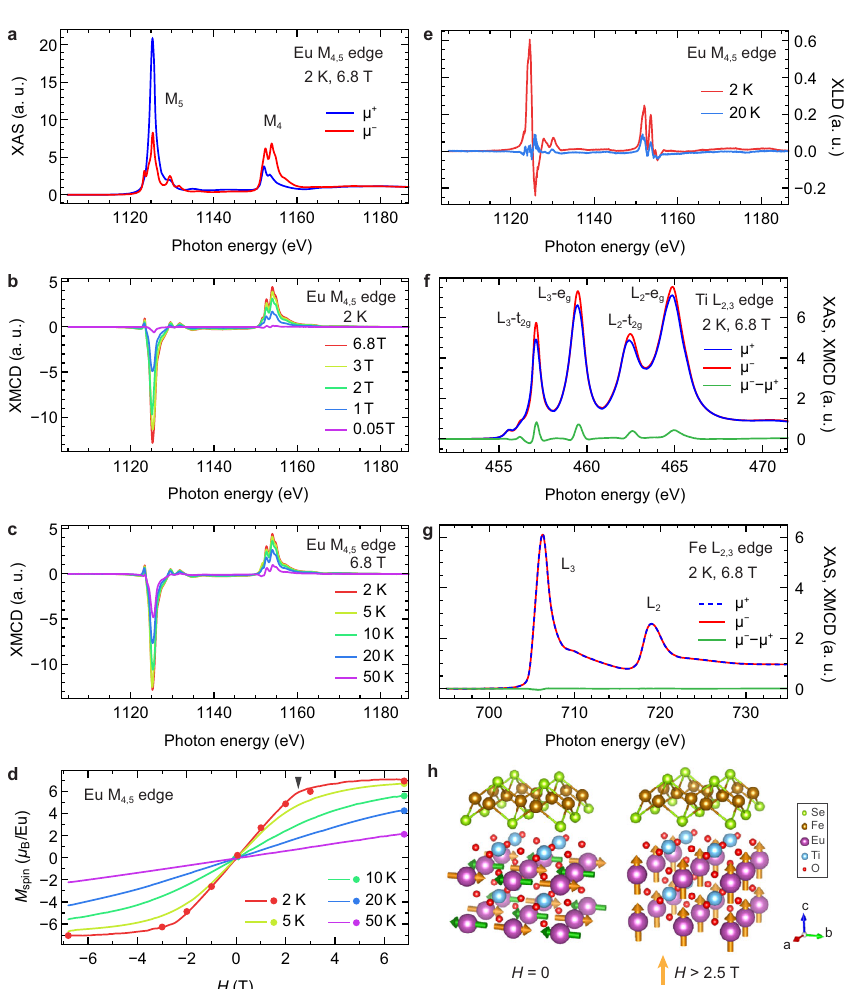
Fig. 2 X-ray absorption spectroscopy (XAS) of FeSe/ETO. a XAS of Eu M 4,5 edge at 2 K in the fi eld of 6.8 T, measured with circularly polarized photons. The incident direction and magnetic fi eld are perpendicular to the sample surface. b X-ray magnetic circular dichroism (XMCD) at the Eu M 4,5 edges at 2 K in various magnetic fi elds. c XMCD at the Eu M 4,5 edges in the fi eld of 6.8 T at various temperatures. d The magnetization contributed by spins on Eu atoms as a function of magnetic fi eld and temperature. The points are the data extracted from the XMCD spectra using the sum rules. The lines are the XMCD intensities at the Eu M 5 peak measured with sweeping fi eld, and normalized to the sum-rule values at 6.8 T for each temperature. e X-ray linear dichroism (XLD) at the Eu M 4,5 edges at zero fi eld at 2 K and 20 K. The incident direction is 60° from the surface normal. f XAS and XMCD at the Ti L 2,3 edges measured with circularly polarized photons. g XAS and XMCD at the Fe L 2,3 edges measured with circularly polarized photons. h Illustration of the spin alignment in the FeSe/ETO heterostructures with different external fi